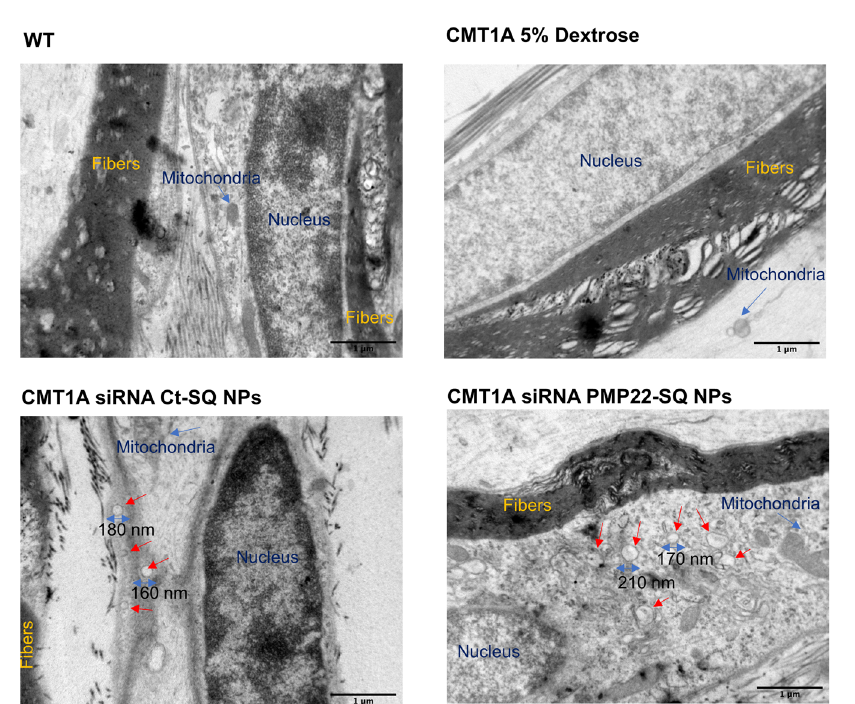
Fig. 5 siRNA PMP22-SQ NPs and siRNA Ct-SQ NPs can reach the sciatic nerve and Schwann cells. Representative TEM images of ultrathin longitudinal sciatic nerves sections of ×25 k magni fi cation of WT, CMT1A mice 5% dextrose, CMT1A siRNA Ct-SQ NPs and CMT1A siRNA PMP22-SQ NPs. The red arrows show vesicles having the same size as the nanoparticles in the CMT1A siRNA Ct-SQ NPs and siRNA PMP22-SQ NPs groups and, were found to be localized in the cytoplasm of Schwann cells. The blue arrows highlight the mitochondria that are differentiated from the vesicles. Scale bar 1 µ